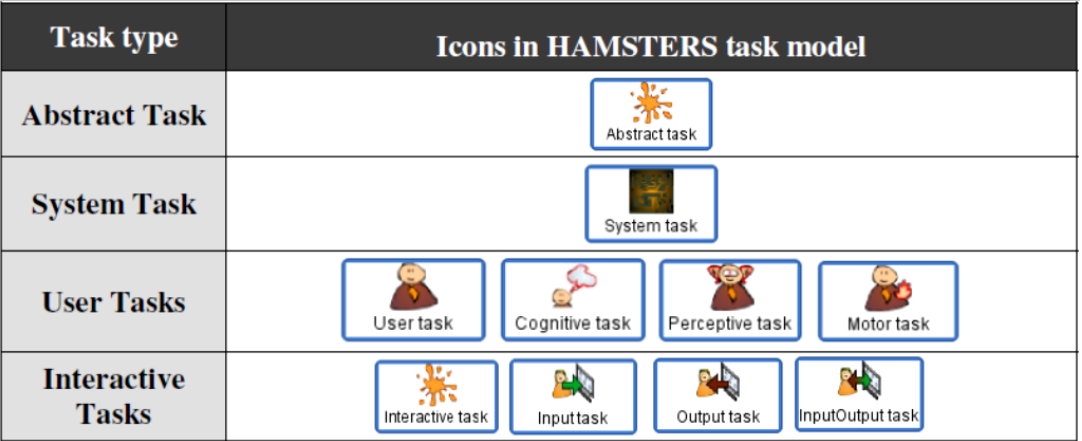
Table 1. Task types in HAMSTERS